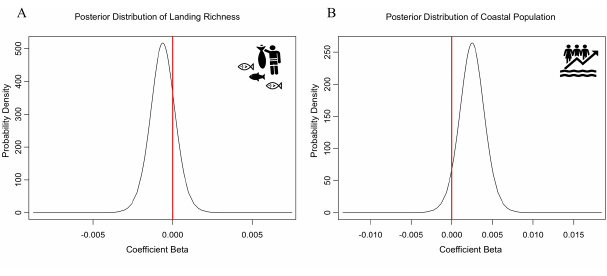
Fig. 5 . Posterior probabilities of the relevant effects of the Bayesian model to landing richness (A) and coastal population (B) on coastal